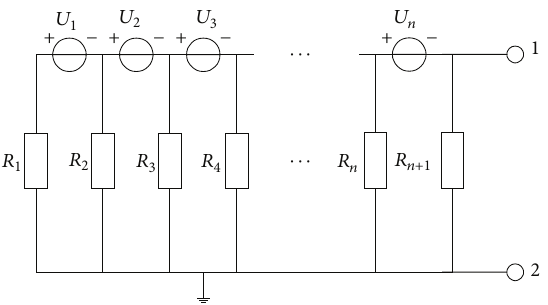
Figure 11: The internal insulation resistance of series connected batteries.